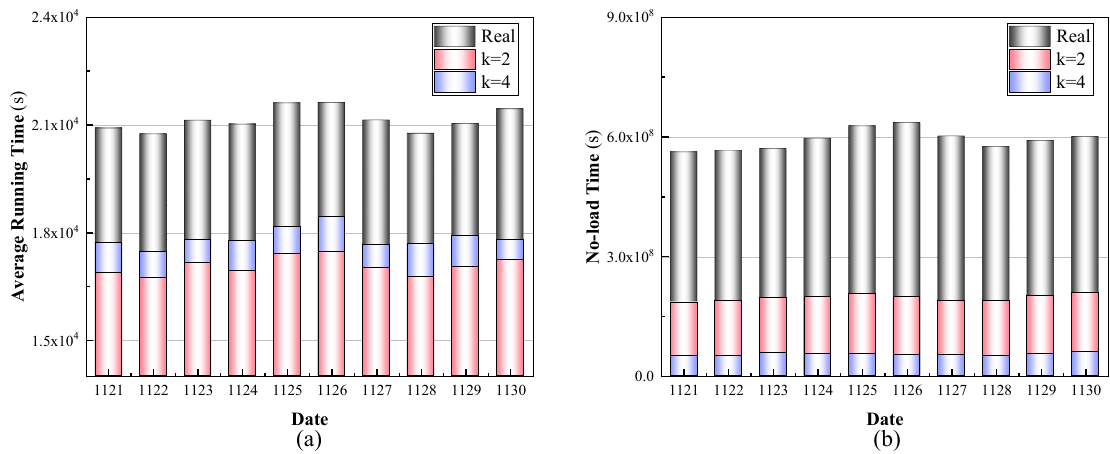
Figure 10. Comparison of average running time and no-load time under different travel paths. ( a ) shows the average running time and ( b ) shows the no-load